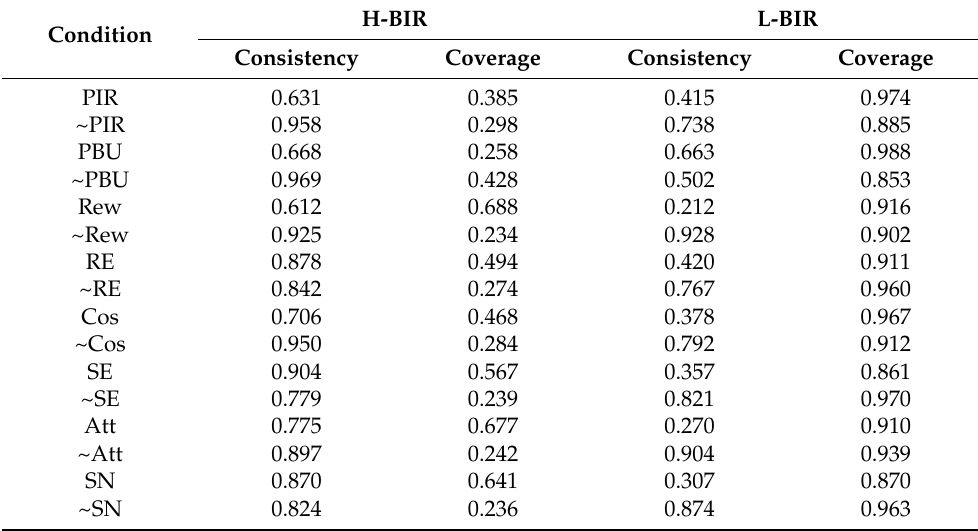
Table 6. Necessary conditions analysis.